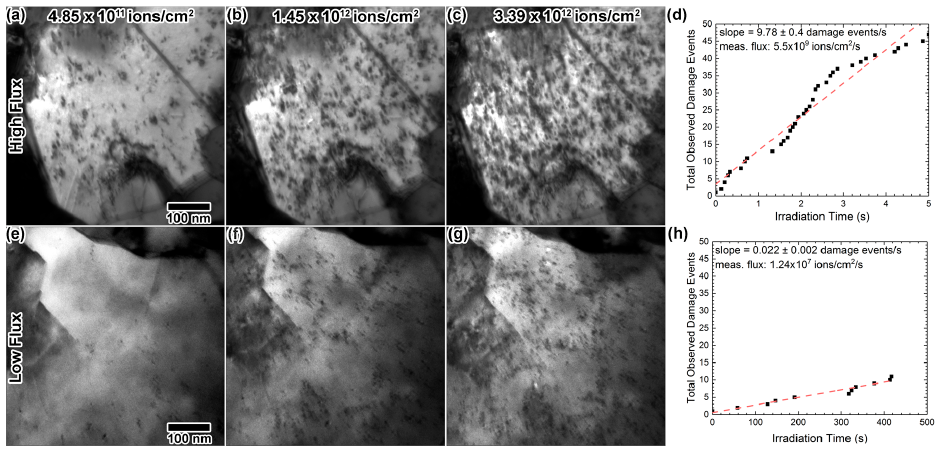
Figure 5. TEM images from in situ 2.8 MeV Au 4+ irradiation into a Au foil using dose rates of 9.69 × 10 10 ( a – c ) and 9.38 × 10 8 ions/cm 2 ·s ( e – g ), at fluences of 4.85 × 10 8 , 1.45 × 10 12